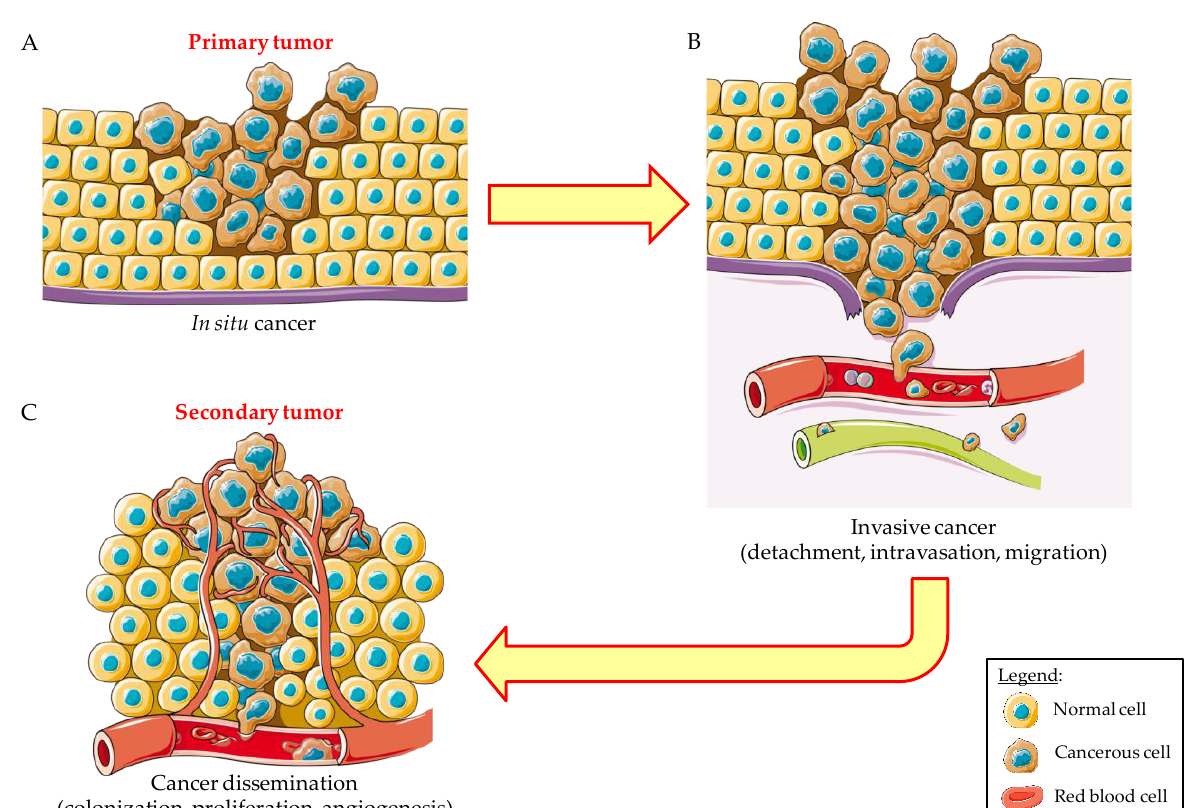
Figure 6. Schematic representation of the metastatic process. Metastasis is a multi-stage process starting with the formation and growth in situ of the primary tumor ( A ). Some tumors can become invasive due to the detachment of cells (CTCs) that are able to enter blood or lymph vessels, a process known as intravasation, and migrate to sites far from the starting point ( B ). The following step is the dissemination of cancer occurring when “traveling cells” extravasate (exit blood or lymph vessels) and colonize new sites forming secondary tumors ( C ). Once in the new sites, cancerous cells are able to proliferate and recruit the blood vessels (angiogenesis) needed for trophic support. (Created with https://smart.servier.com, accessed on 15 December 2021).